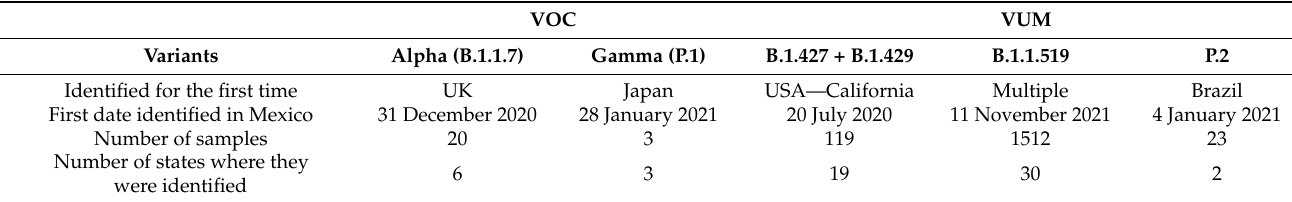
Table 1. VOC/VUM variants identified in the first year of the pandemic in Mexico.